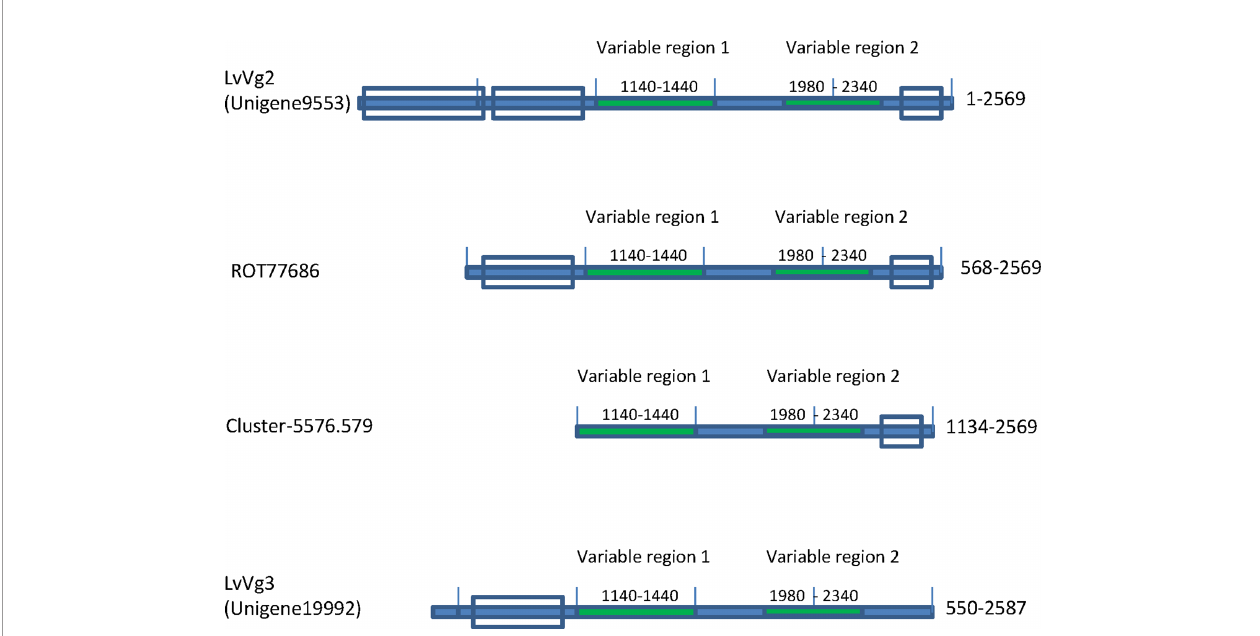
FIGURE 3 | Presence of two other Vg transcripts (i.e. LvVg2 and LvVg3 ) in the whiteleg shrimp L. vannamei. Domain structures of LvVg2 and LvVg3 isolated from the transcriptome are shown. Unigene 9553 was most similar (>99% aa identity) to the deduced protein from the L. vannamei genome project (ROT77686), followed by MeVg2 of the sand shrimp M. ensis (XP027235402) (i.e. 56% aa identity) and another reported Vtg (Genbank# AAP76571). Cluster-5576.579 was a transcript identi fi ed from the hepatopancreas of Vibrio hervyei challenged L. vannamei. Unigene19992 was a partial transcript for LvVg3 as it encoded a truncated Vg with coding sequence from AA550-2587 as compared to LvVg1